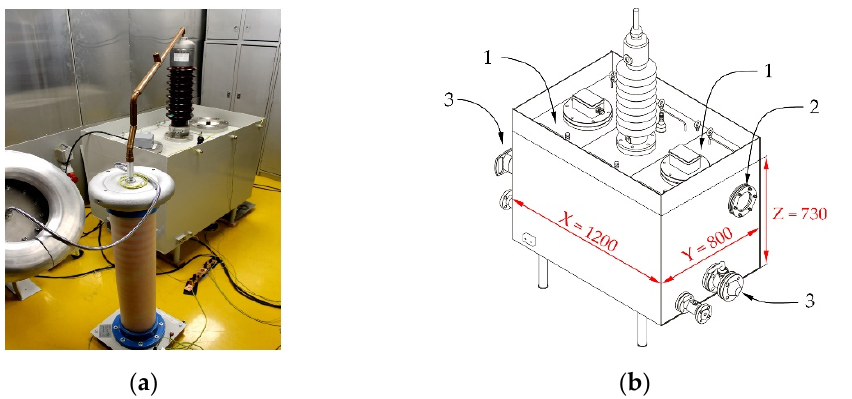
Figure 15. Realistic transformer tank. ( a ) Test setup arranged in the high-voltage laboratory; ( b ) schematic diagram of the transformer tank: 1—inspection hatch with UHF sensors (or plain cover); 2—inspection hatch with the dielectric window made of poly (methyl methacrylate) (PMMA); 3—oil drain valve [27].